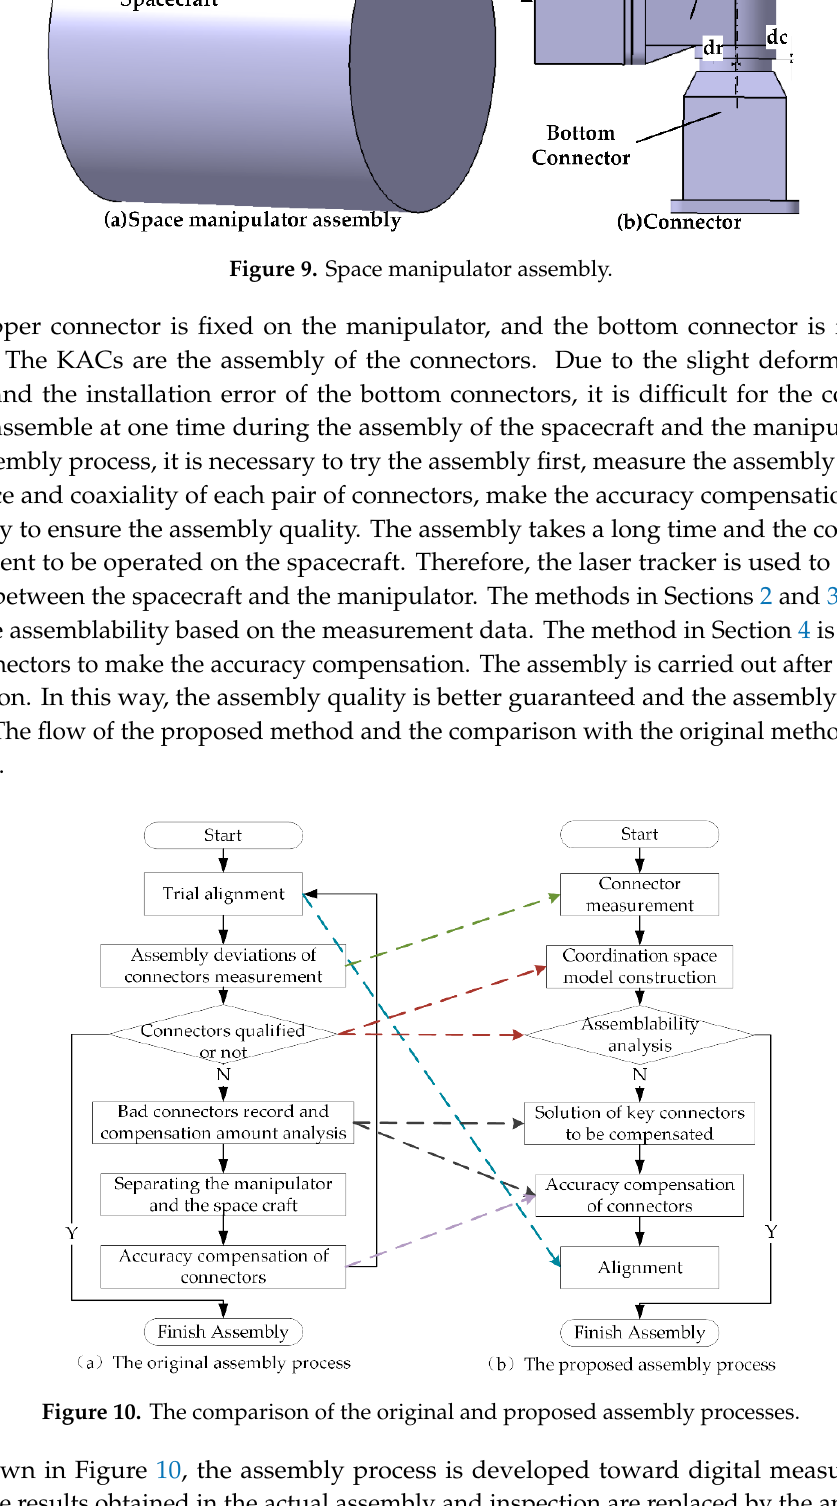
Figure 11. Measurement auxiliary tool. After inserting the shaft into the corresponding hole, measure the four holes of the measurement auxiliary tool. The measurement data are processed as the position 𝑝 and orientation 𝑝𝑜(cid:4652)(cid:4652)(cid:4652)(cid:4652)⃑ . (cid:4688)𝒑𝒐(cid:4652)(cid:4652)(cid:4652)(cid:4652)(cid:4652)⃑ = (𝒄 (cid:3119) (cid:2879)𝒄 (cid:3117) )×(𝒄 (cid:3120) (cid:2879)𝒄 (cid:3118) ) |(𝒄 (cid:3119) (cid:2879)𝒄 (cid:3117) )×(𝒄 (cid:3120) (cid:2879)𝒄 (cid:3118) )| 𝒑 = (cid:2869) (cid:2872) ∑ 𝒄 (cid:3036) − 𝑙 ∙ 𝒑𝒐(cid:4652)(cid:4652)(cid:4652)(cid:4652)(cid:4652)⃑ , (26) where 𝒄 (cid:2869) , 𝒄 (cid:2870) , 𝒄 (cid:2871) , and 𝒄 (cid:2872) are the points measured by the laser tracker.